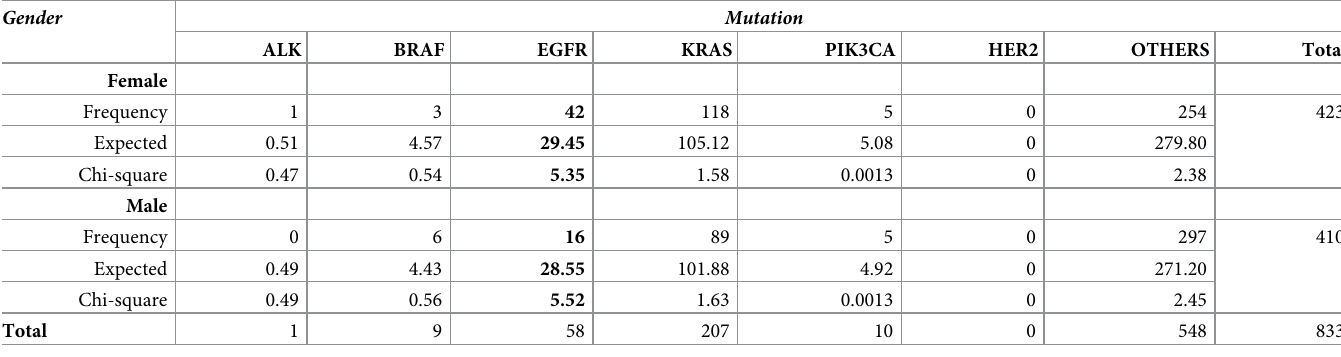
Table 3. Statistics table of gender by mutation in the 833 samples.